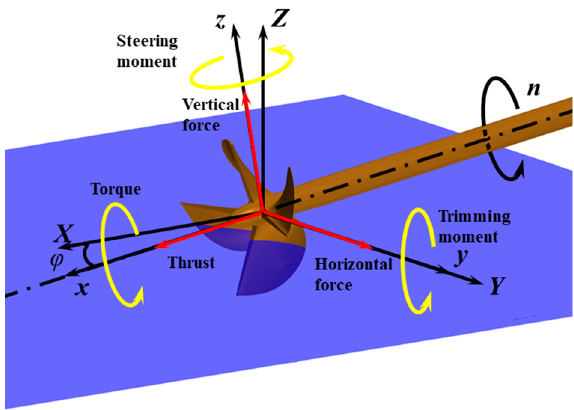
Figure 3. Global and local coordinates, forces and moments along and about different axis.